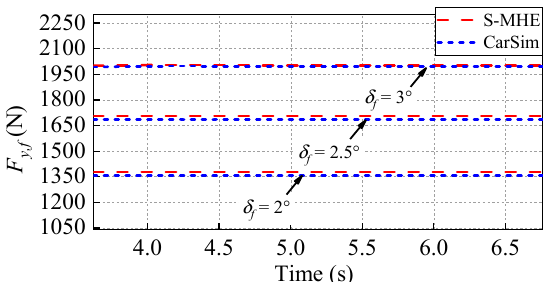
Figure 12. A partially enlarged view of front lateral tire force.